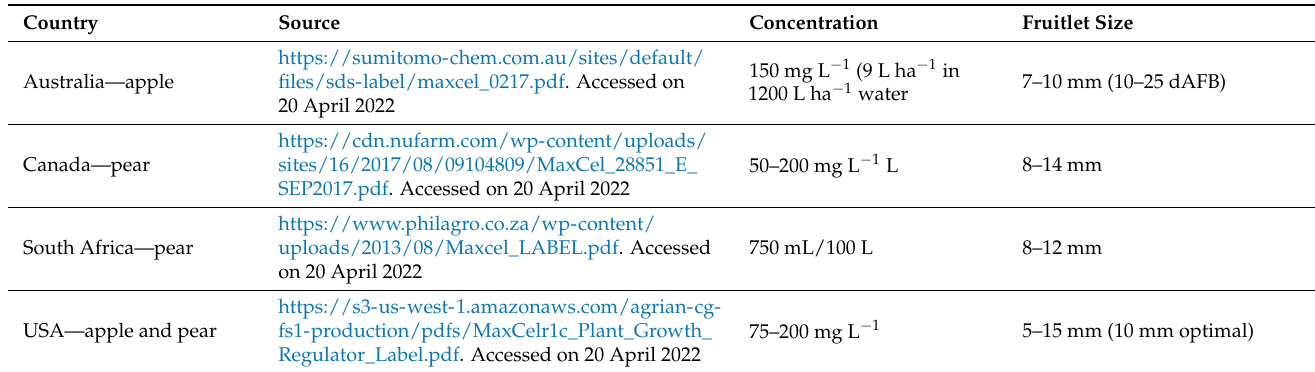
Table 10. Label recommendations for 6-benzyladenine (BA) as a post-bloom thinner in pome fruits. Concentration Fruitlet